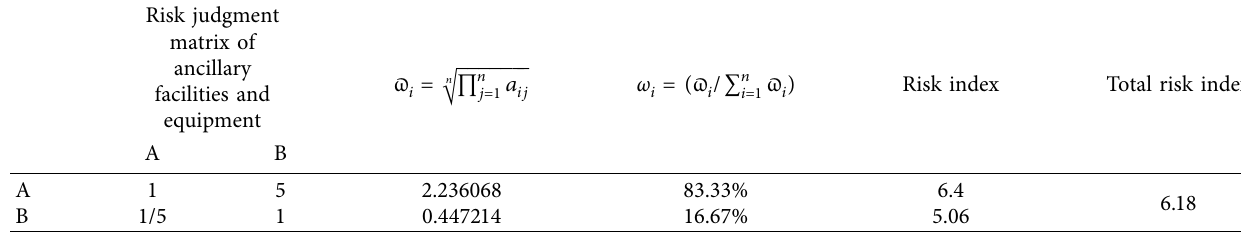
Table 36: Risk judgment matrix of ancillary facilities and equipment.